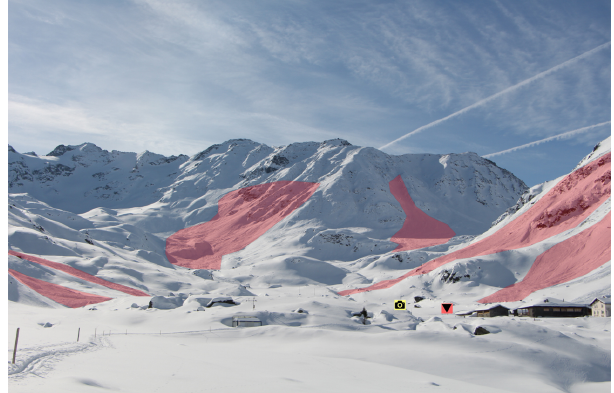
Figure 3. Picture of the Dischma field site facing south. The pic- ture was taken on 15 March 2017 shortly after a period of high avalanche activity and several recent avalanches were observed (red areas). The triangle indicates the location of the seismic array, and the camera icon indicates the location of the automatic camera.